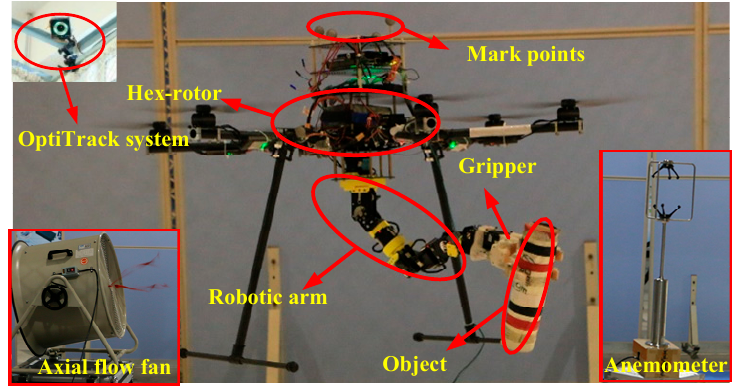
Figure 4. Experimental platform.